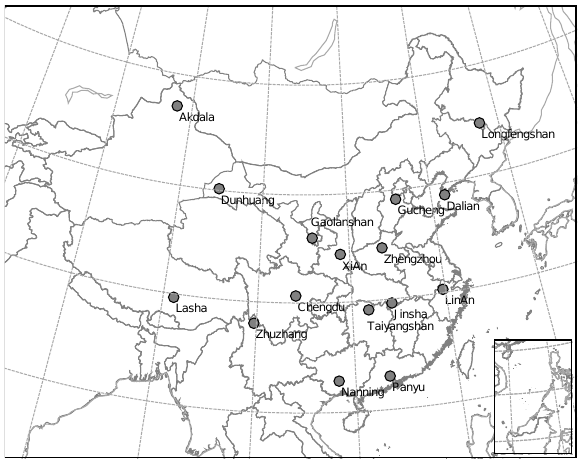
Fig. 1. Locations of sixteen CAWNET